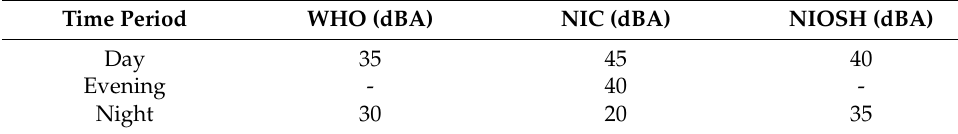
Table 1. Standards SPLs in dBA recommended by different